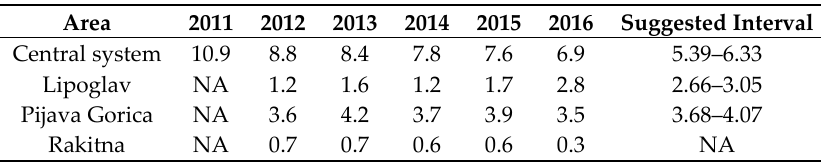
Table 1. Comparison of ILI factors in the period of